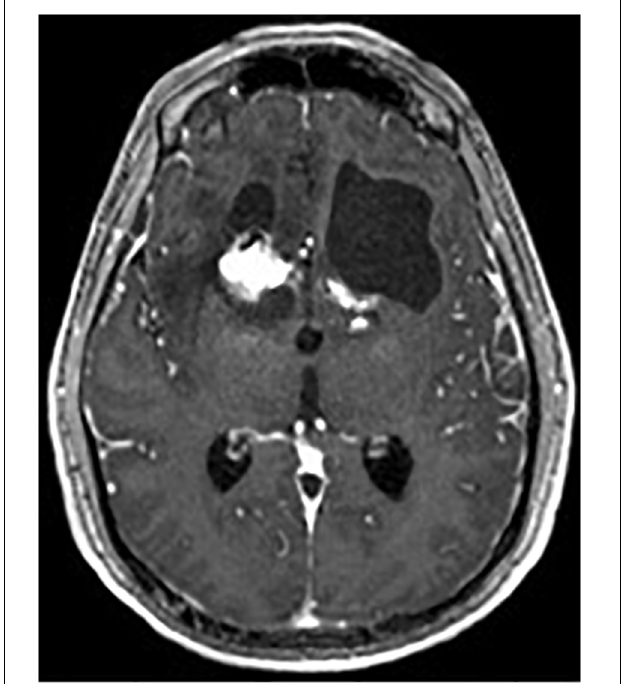
FIGURE 9 | Axial T1-weighted MRI with contrast of brain cyst in the left hemisphere after gamma knife capsulotomy.